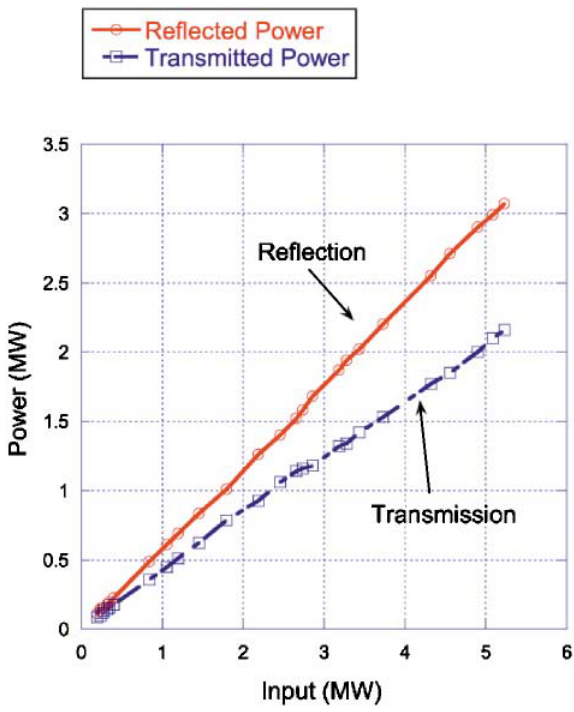
FIG. 21. (Color) Input versus transmission and reflection power.